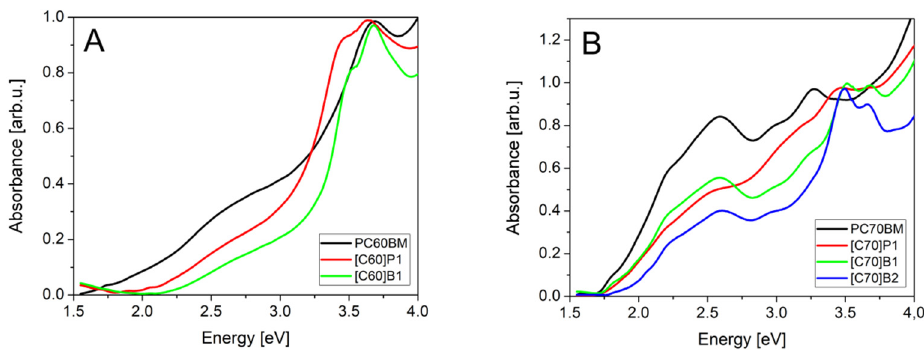
Figure 6. Absorption spectra of investigated fullerene derivatives: ( A ) C 60 , ( B ) C 70 . Absorption spectra of C 70 fullerene derivatives in Figure 6B showed that the standard material PC70BM had threshold at 1.7 eV and reached first maximum at 2.6 eV. These two features remained the same for all C 70 fullerene derivatives and differences were visible only for the strongest second absorbance peak in the energy range 3.2–3.8 eV. The PC70BM had second absorption peak at 3.25 eV. The absorption threshold at about 1.7–1.8 eV is due to the transitions from the ground singlet S 0 state to the S 1 -derived states [38]. They do not form peaks in the spectra due to very weak oscillator strength. The peak at 2.6 eV in C 70 spectra is related to triplet transition S 0 → T 1 , allowed by lower symmetry of the C 70 molecule.